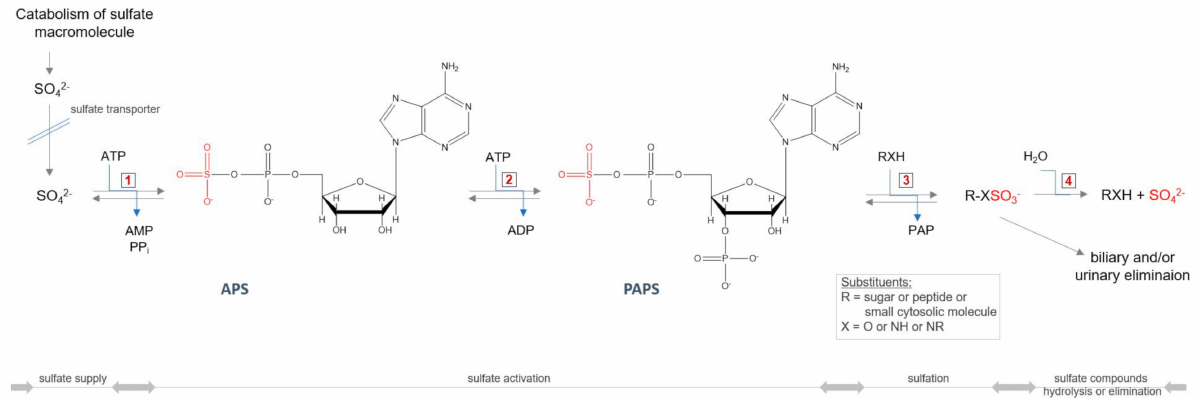
Figure 5. Cellular sulfate reuse pathway. Abbreviations: ATP—adenosine